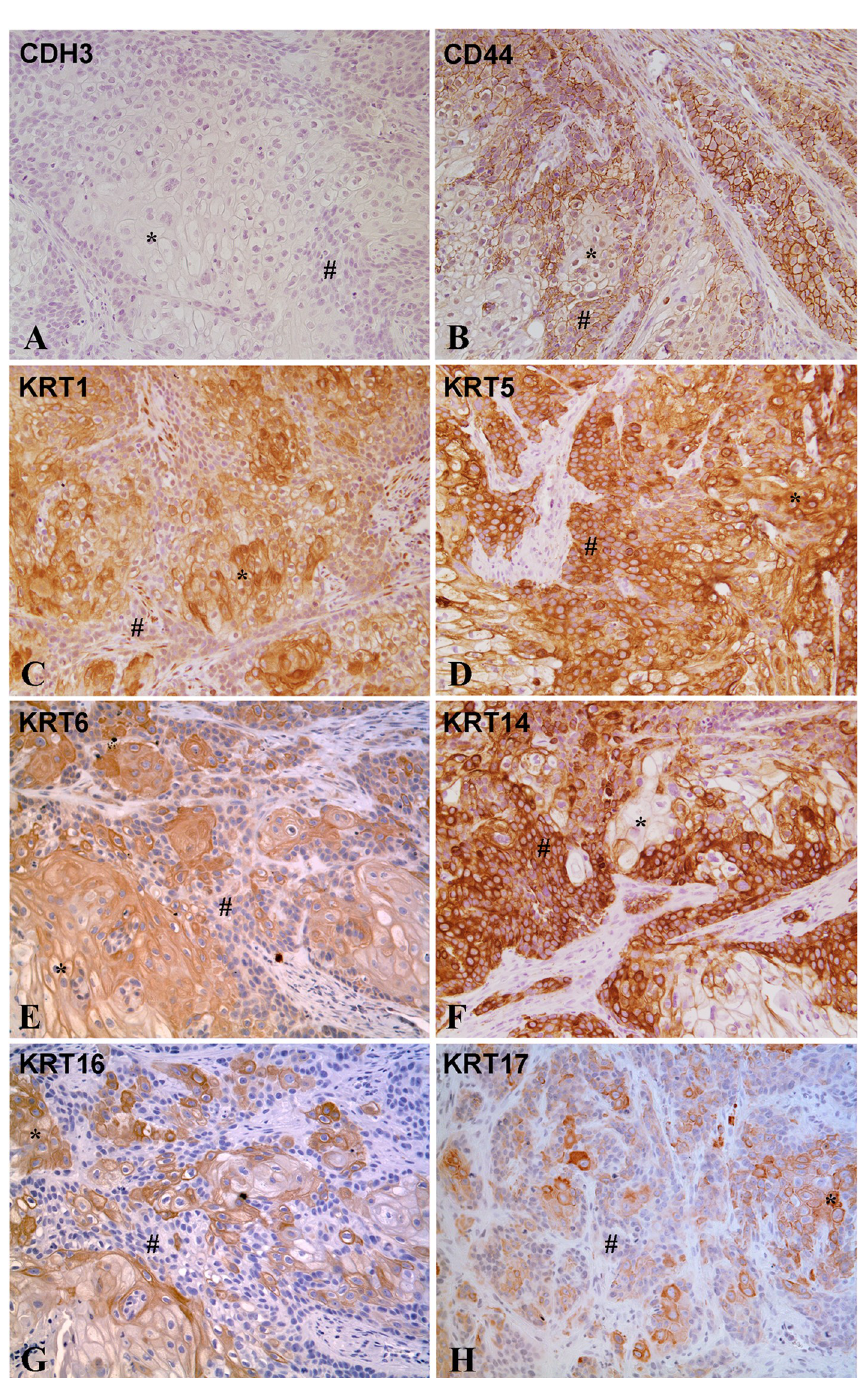
Fig 3. Immuno-histochemical staining for basal markers in tumor transplants generated from As 3+ -transformed cell line (As#3). (A) CDH3. There is no staining in the differentiated ( � ) or the less differentiated areas (#) of the tumor transplants. (B). CD44. There is strong membranous staining for CD44 in the less differentiated cells located at the periphery of the tumor nests (#), whereas the well-differentiated cells located in the center of the tumor nests ( � ) show weak or no staining for CD44. (C). KRT1. The well-differentiated cells ( � ) in the center of tumor nests are strongly positive for KRT1, whereas the peripheral less differentiated cells (#) show weaker staining. (D). KRT5. The staining for KRT5 is diffuse with strong staining in the well-differentiated ( � ) as well as less differentiated (#) areas of the tumor. (E). KRT6. The staining for KRT6 is strong in the well-differentiated cells located in the center of the tumor nests ( � ), whereas the staining is weak to absent in the less differentiated cells (#) located at the periphery of the